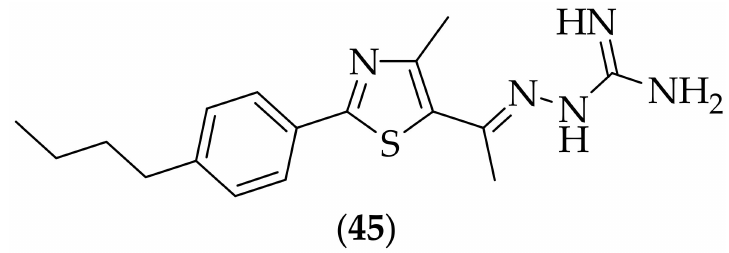
Figure 29. Lead thiazole-aminoguanidine analog ( 45 ).